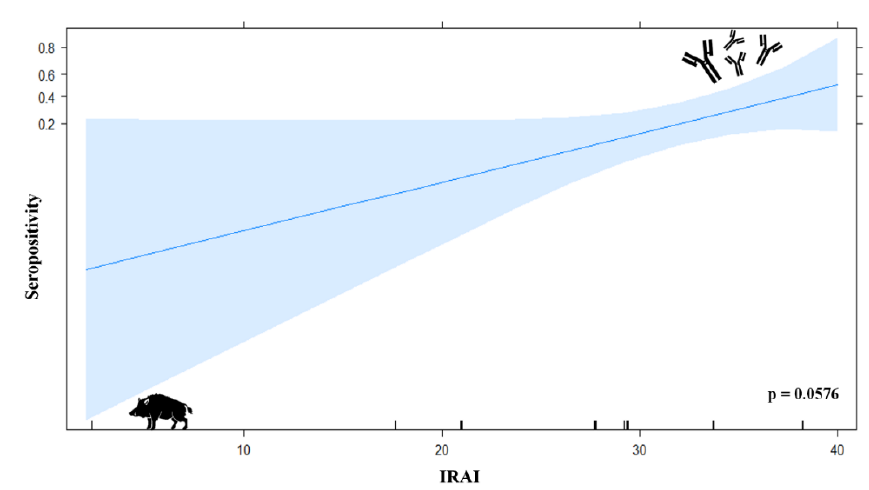
Figure 5. Logistic regression model. Integrated relative anthropization index (IRAI) values are shown on the x -axis, and seropositivity are shown on the y -axis. The probability that an individual is positive increases as IRAI increases. Confidence interval is shown in pale blue. Initially wide, it becomes narrower as IRAI increases. The behavior of the confidence interval is related to the sample size.